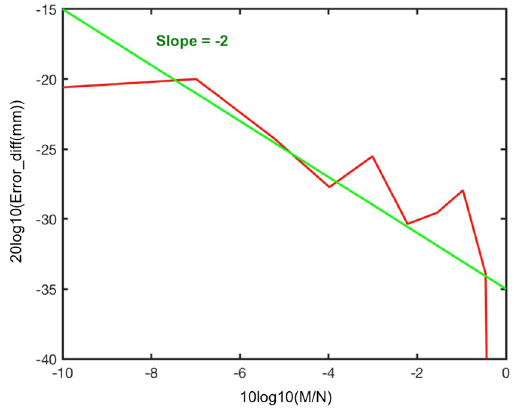
Figure 22. Differential displacement error in function of M/N for a stable point in the open pit mine.